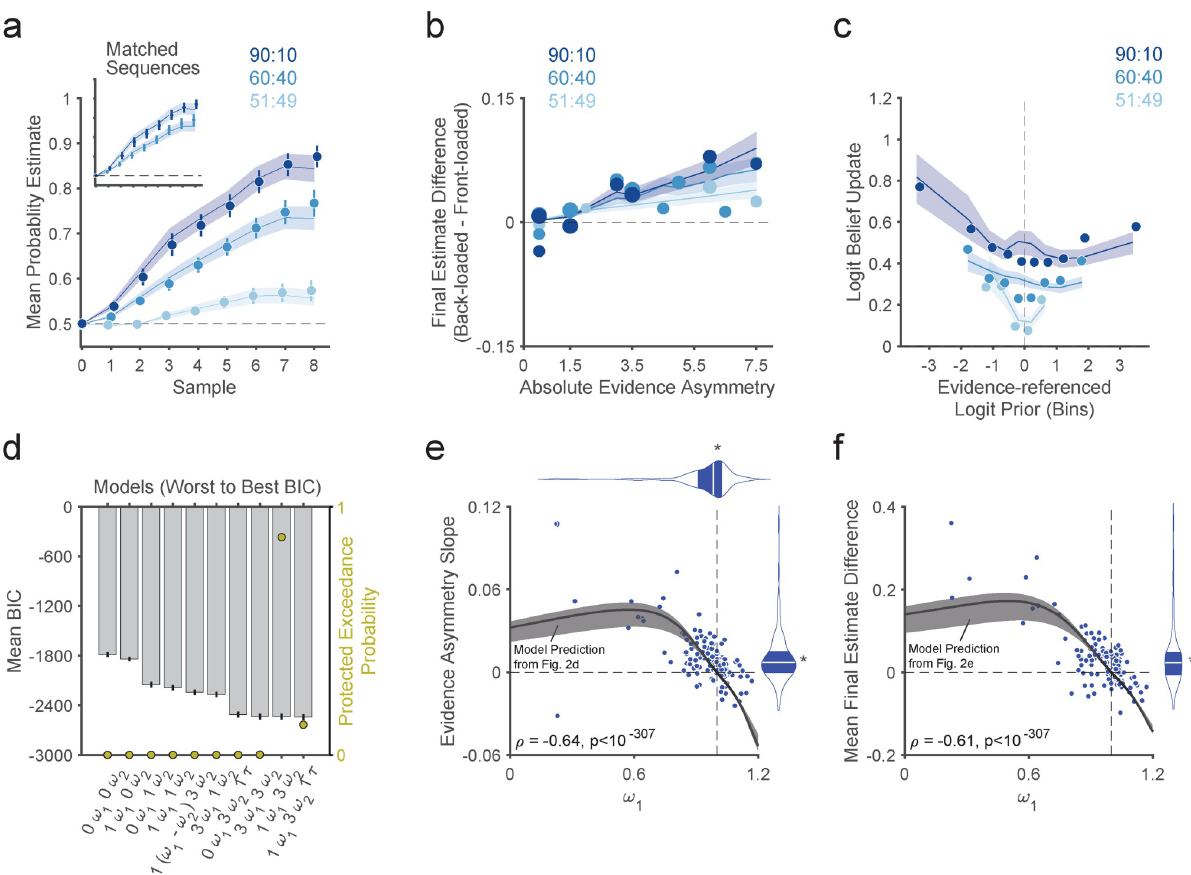
Fig 3. Study 1 participants show behavioral signatures of sequential base-rate neglect which scale with model-derived prior underweighting. (a) Group mean of average probability estimates over bead draws for each bead-ratio condition. Participants updated beliefs progressively toward the correct hidden box with steeper slopes for stronger evidence. The inset shows the same data limited to matched (identical) sequences for the 60:40 and 90:10 conditions. Solid lines and shaded regions reflect the mean and standard error of the mean (SEM) of the weighted Bayesian model fits across participants. (b) Group mean of final estimate difference as a function of evidence asymmetry. Each data point shows the difference in the probability estimate after 8 beads for a back-loaded and a front-loaded sequence comprising a mirror-opposite pair, with positive values indicating higher estimates for back-loaded sequences consistent with recency bias. Solid lines and shaded regions reflect the mean and SEM of the weighted Bayesian model fits. Consistent with model predictions (Fig 2B), the data shows a recency bias scaling with evidence asymmetry. (c) Group median of individual medians for the magnitude of logit-belief updates as a function of the logit prior with respect to the color of the current bead sample, divided by bead- ratio condition. The x-axis is discretized into bins equivalent to 0.1 increments of the prior belief in probability space (with a lower limit of 0.01 and an upper limit of 0.99; data only binned for visualization). The y-axis represents the magnitude of the logit-belief updates (the difference in the log-odds of the prior and posterior beliefs). Solid lines and shaded regions reflect medians and 95% bootstrapped confidence intervals of the weighted Bayesian model fits. Although not displayed for visual clarity, the confidence intervals for the raw data overlap substantially with the model fits. For visualization only, we excluded extreme outlier or noisy data points (logit belief updates > 2, individual median values based on less than 3 data points for a given bin, group median values based on less than 25% of individuals) for a total exclusion of 6.96% of the data. Consistent with model predictions (Fig 2C), the data shows prior-dependent belief-updating with less updating for prior-consistent evidence (right of the vertical dashed line; i.e. an overall negative slope). Note that at the group level this effect appears to be non-monotonic (with slightly positive slope towards the rightmost end) due to aggregation of data across individuals with different ω 1 values, since individuals with ω 1 > 1 are predicted to have and exhibit more updating to prior- consistent evidence (i.e., positive slopes; S2 Fig). (d) Formal model comparison for data from study 1. We compared 10 different models as in our previous work [31]. Each model is defined by its free parameters, which are reflected on the x-axis. See S28 Table for details. The winning model was defined as the model with the highest protected exceedance probability, which was the same as in our previous work [31] and in study 2 (S6 Fig). (e) The evidence asymmetry slope (equivalent to a single line fitted across all conditions in panel b) is plotted against the prior-weight ω 1 , showing a negative correlation. This correlation closely follows model predictions indicated by the black line (as in Fig 2D but with shaded regions including variability in likelihood-weight ω 2 parameters between the 25 th and 75 th percentile range of observed values in our previous work [31]). Marginal violin plots show group medians and interquartile ranges. ( f) The mean final estimate difference is shown against ω 1 , again showing a correlation that follows the model prediction (black line as in Fig 2E). Marginal violin plots show group medians and interquartile ranges. (e, f) Asterisks indicate a significant sign-rank tests of group medians against the corresponding reference values indicated by the dashed lines. Note that results in (e) and (f) were robust to the exclusion of outliers with an ω 1 more than 3 scaled median absolute deviations [52] from the median ( ω 1 < 0.75; 11 outliers): after their removal, the correlation between ω 1 and the evidence asymmetry slope was still significant ( ρ = -0.58, p < 10 − 307 ), as was the correlation between ω 1 and the mean final estimate difference ( ρ = -0.53, p = 2.32 x 10 − 12 ). Posterior predictive checks further recapitulate the range of values in the data (S10–S12